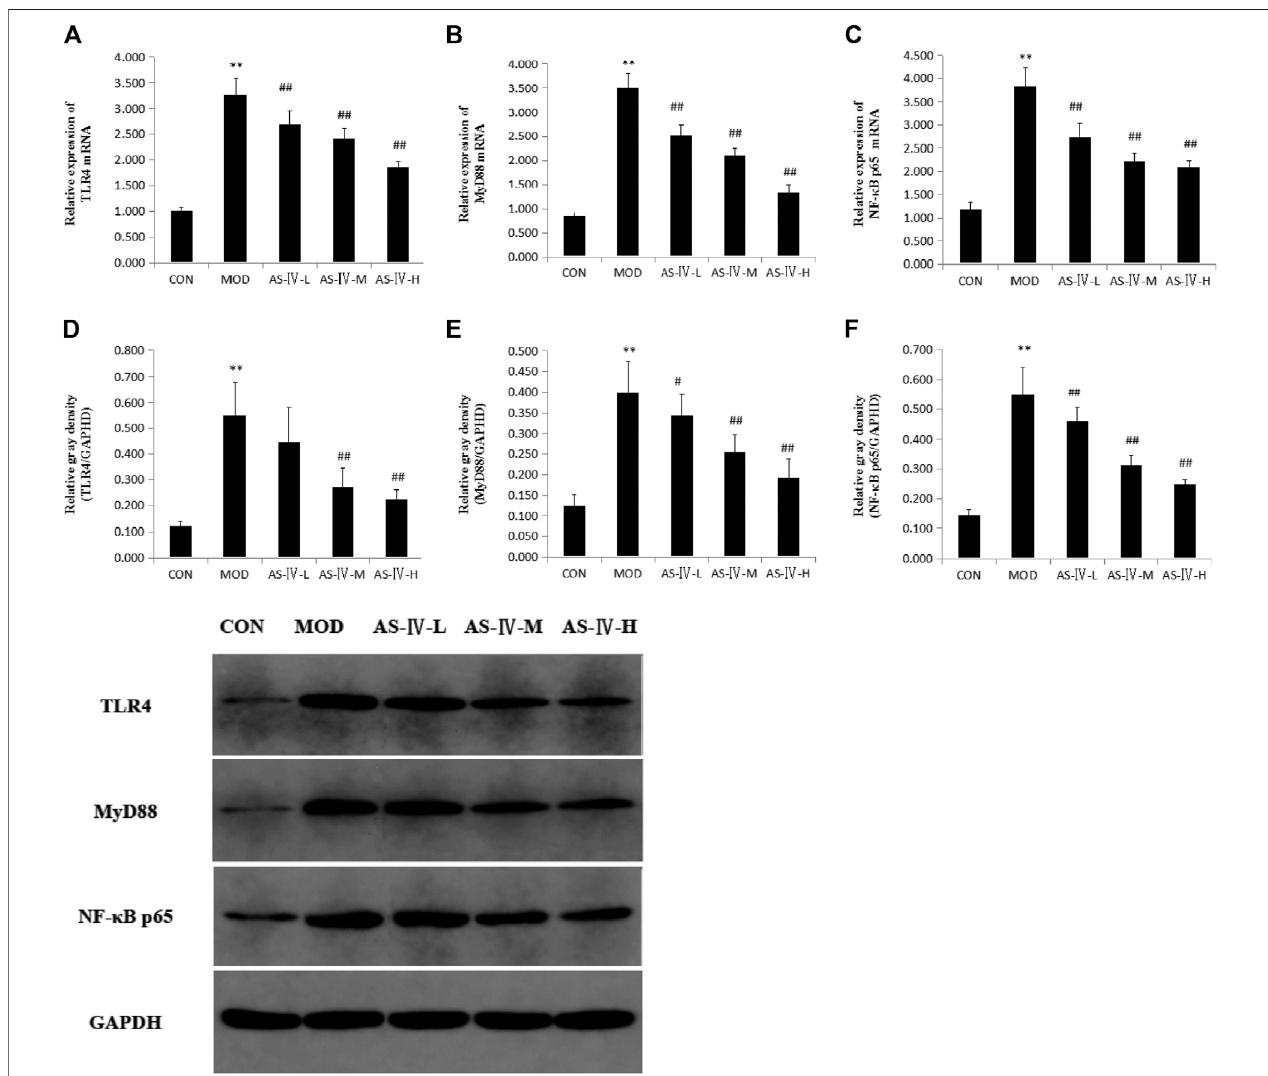
FIGURE 5 | Effects of astragaloside IV on expression of hepatic TLR4, MyD88, and NF- κ B p65 in NAFLD rats. (A) TLR4 mRNA expression. (B) MyD88 mRNA expression. (C) NF- κ B p65 mRNA expression. (D) TLR4 protein expression. (E) MyD88 protein expression. (F) NF- κ B p65 protein expression. (G) Representative proteinexpressionbandsofhepaticTLR4,MyD88,andNF- κ Bp65wereanalyzedbyWesternblotting.Datapresentthemean ± SD.Comparisonsbetweentwogroups use t -tests,anddatacomparisonamongmultiplegroupsuseone-wayANOVA.* p < 0.05and** p < 0.01comparedwiththecontrolgroup; # p < 0.05and ## p < 0.01 compared with the model group. CON, control group; MOD, model group; AS-IV-L, astragaloside IV low-dose group; AS-IV-M, astragaloside IV middle-dose group; AS-IV-H, astragaloside IV high-dose group.